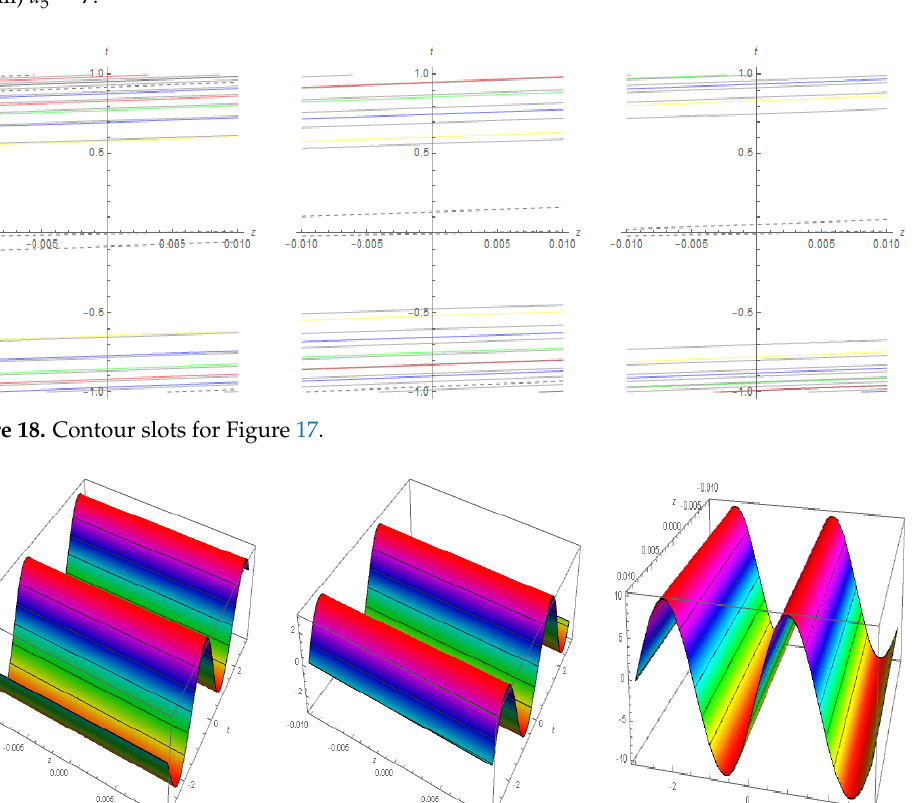
Figure 17. The MS graphs of the solution ∆ 9 in Equation (37) are made for values of a 6 = 0.2, c 1 = 1, k 1 = 3, a 4 = 0.1, b 1 = 10, b 2 = 2, c 2 = 2, k 2 = 3. Three-dimensional graphs at (i) a 5 = − 5, (ii) a 5 = 3 and (iii) a 5 = 7.